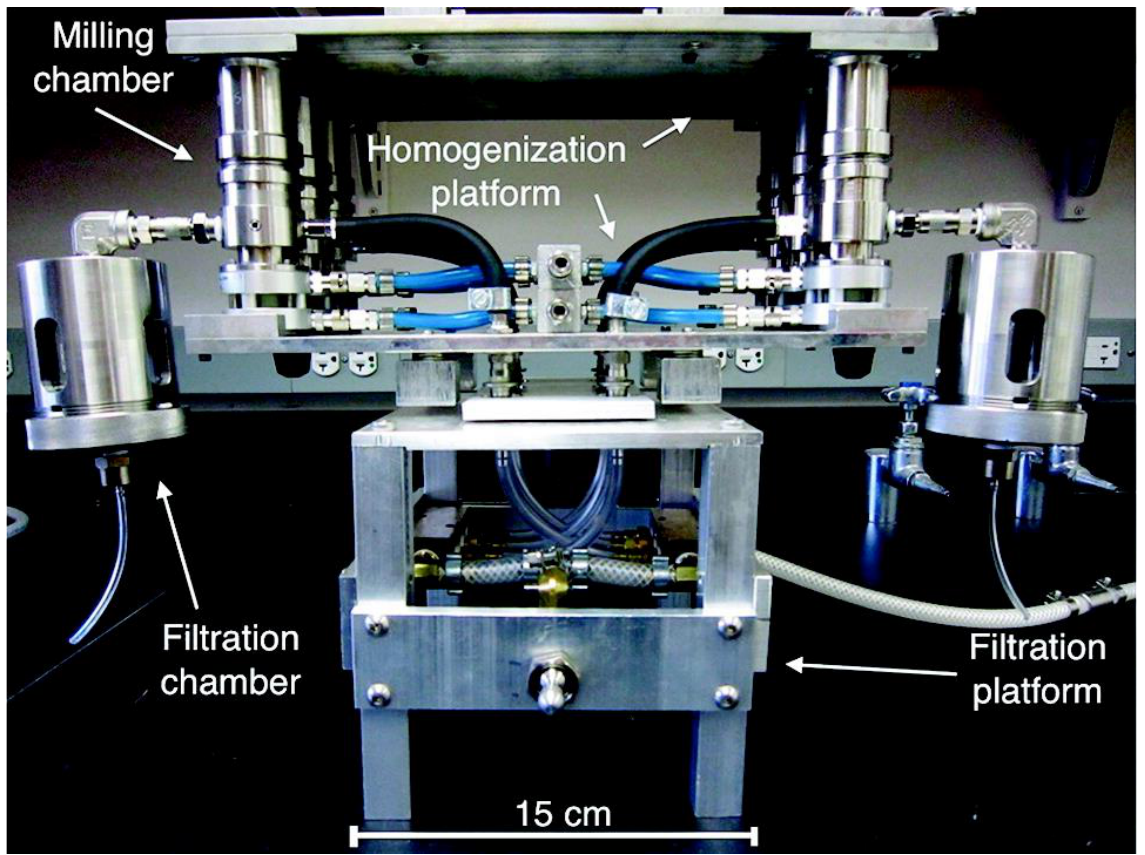
Figure 3. Photograph of the major components of the assembled SAMBED. The air compressor and vibrational shaker are not shown. Reprinted with permission from [50]. 2012, American Chemical Society.